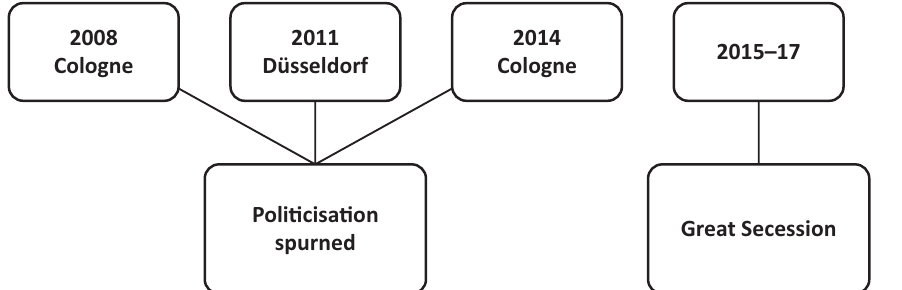
Figure 4. Four attempts at vitalising the Turkish issue (own